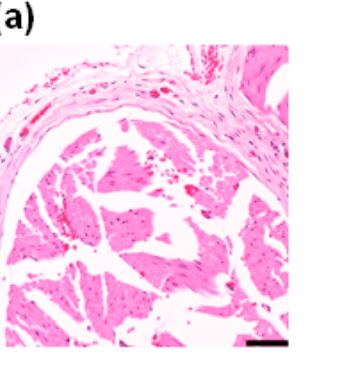
Figure 6. Bilateral sciatic nerves of the sham- and laser-irradiated rats were evaluated for pathology by HE staining (n = 3 each). There were no differences in findings between all the conditions, and no histopathological changes such as nerve damage due to laser irradiation were observed. ( a ) Representative image of the left sciatic nerve of sham-irradiated rats (intact). ( b ) Representative image of the right sciatic nerve of sham-irradiated rats (nerve exposed). ( c ) Representative image of the right sciatic nerve of laser-irradiated rats (nerve exposed). Black bars: 50 µm.